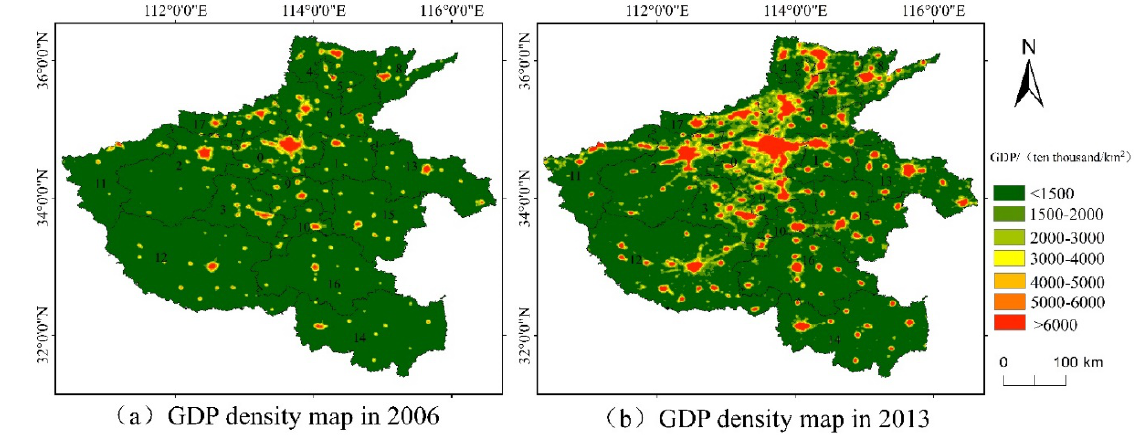
Fig.4 GDP spatial distribution map in 2006 and